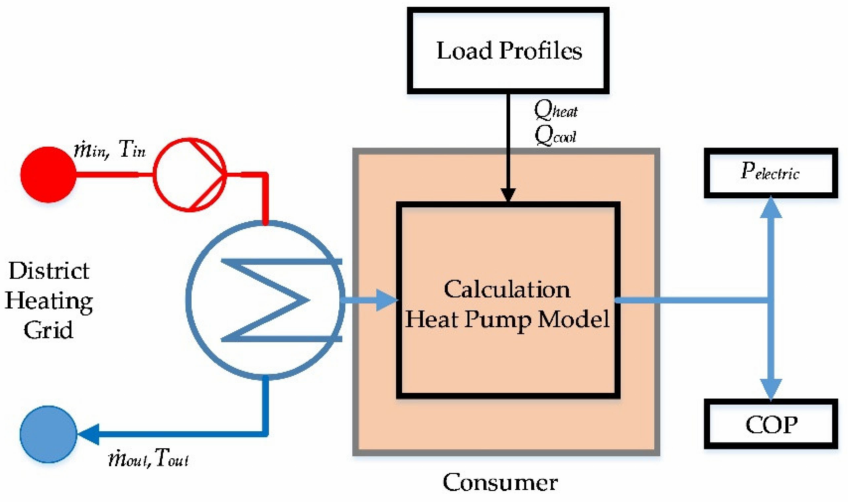
Figure 2. Scheme of a single consumer